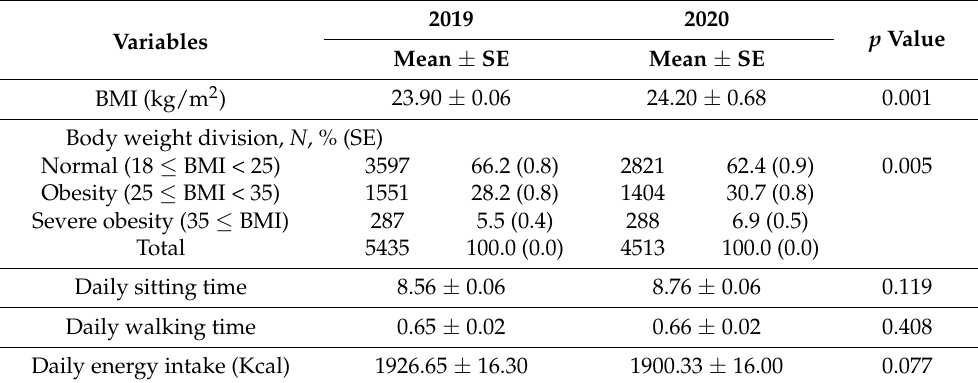
Table 2. Body weight division, physical activity, and nutrition characteristics in Korean adults aged 19 and